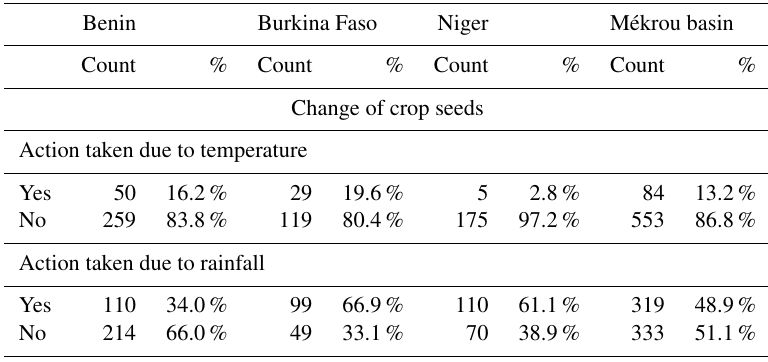
Table 6. Household mitigation measures.